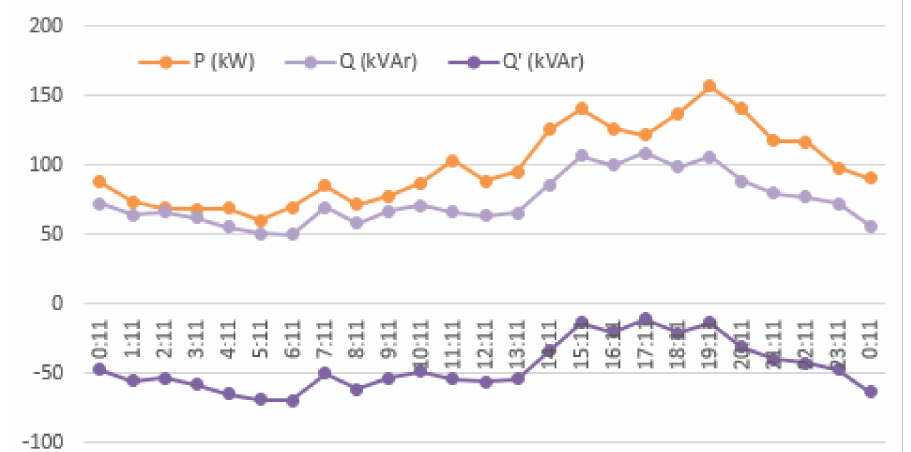
Figure 3. Powers delivered by the transformer in 24 h of a weekday: active P ( kW ) and reactive power Q (cid:48) ( kVAr ) , registered by the Fluke 435 Series II; and reactive power supplied with no capacitor banks Q ( kVAr ) (a negative sign indicates capacitive reactive powers).